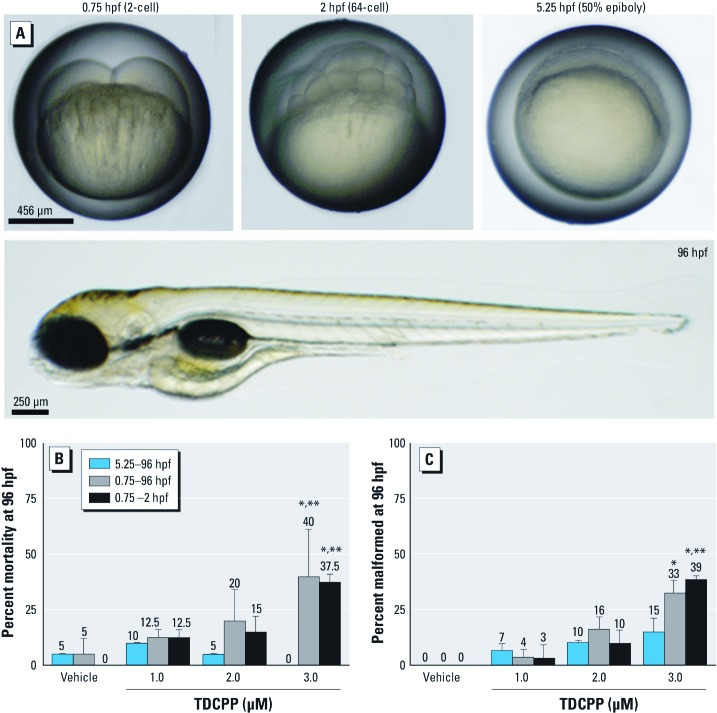
Effect of TDCPP exposure during cleavage on developmental toxicity. (A) Brightfield images of normal zebrafish stages used to define exposure windows. (B) Mean percent mortality (± SD) and (C) mean percent malformed (± SD) embryos at 96 hpf following static exposure to TDCPP during 5.25–96 hpf, 0.75–96 hpf, or 0.75–2 hpf. For exposures during 0.75–2 hpf, embryos were incubated in vehicle (0.1% DMSO) during 2–96 hpf. All surviving 96-hpf larvae that exhibited a range of abnormal phenotypes were included in malformation data. n = 3 beakers/treatment. *p < 0.05 for within–exposure window effects compared with vehicle controls. **p < 0.05 for within-treatment effects compared with exposures initiated at 5.25 hpf.